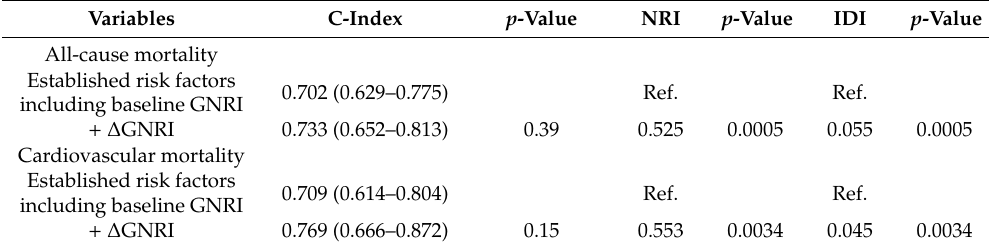
Table 3. Predictive accuracy of annual change in GNRI for